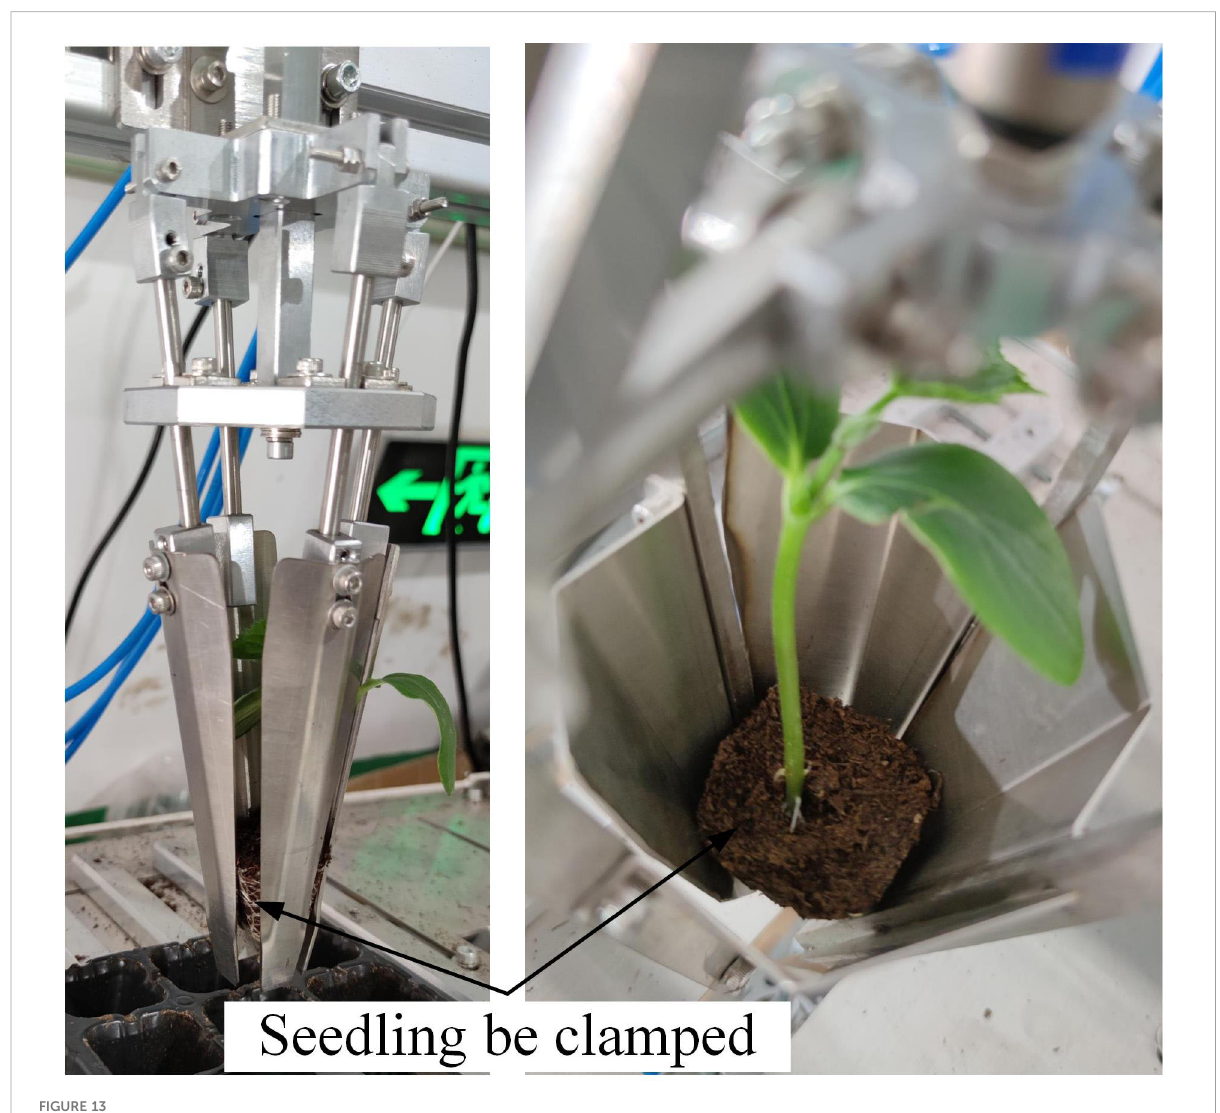
FIGURE 13 The actual seedling clamping result of new